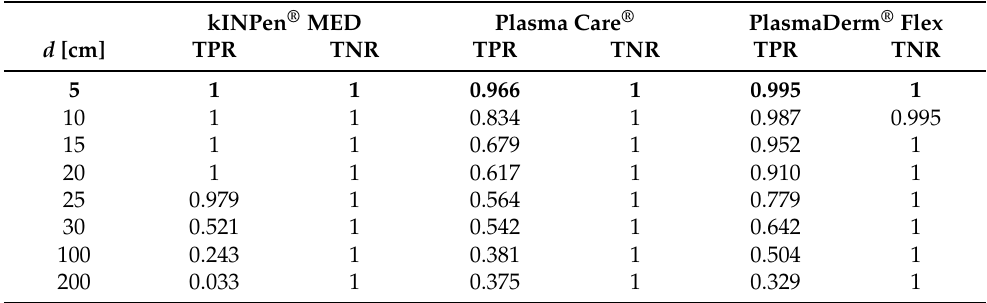
Table 2. Average sensitivity (TPR) and specificity (TNR) of all there devices based on the data collected from the measurements in all conditions. Best scores are presented in